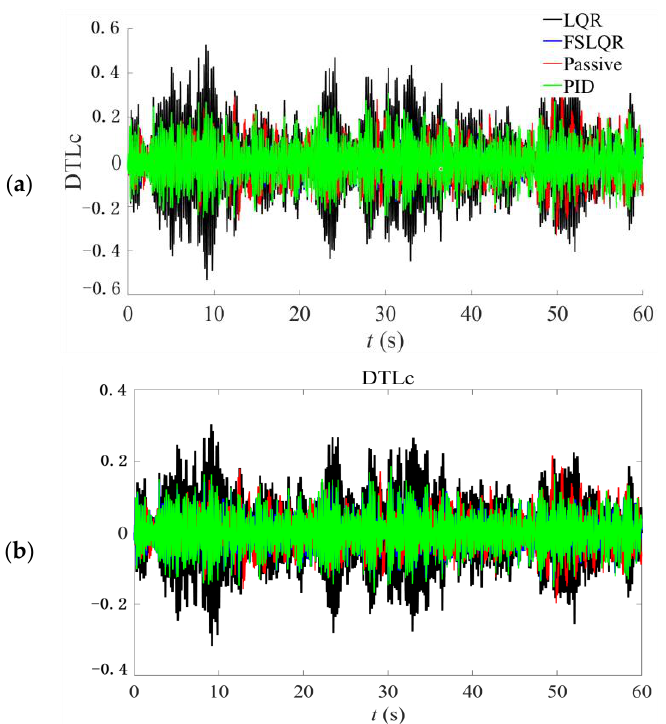
Figure 8. The tire’s loading coefficient responses of DTLc under random excitation, ( a ) under the national standard C-grade road surface, ( b ) under the national standard B-grade road surface.